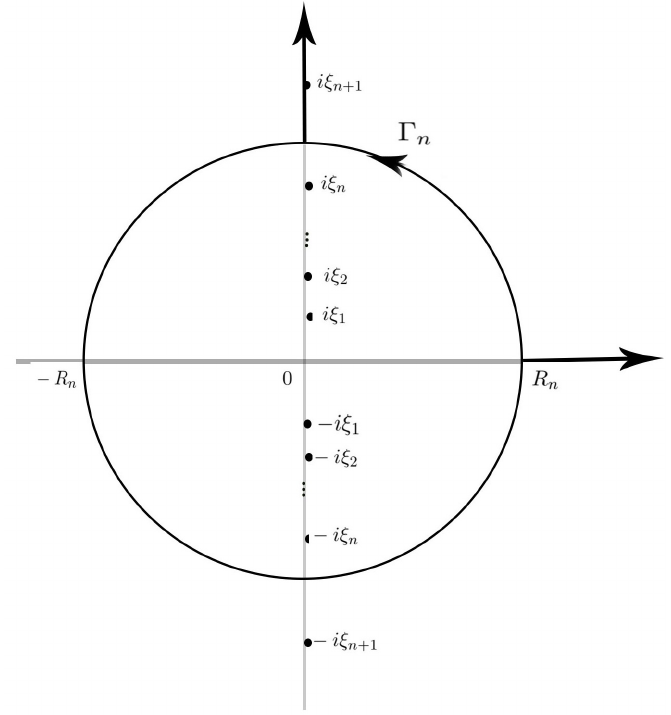
Figure 1. The contour Γ n in Lemma